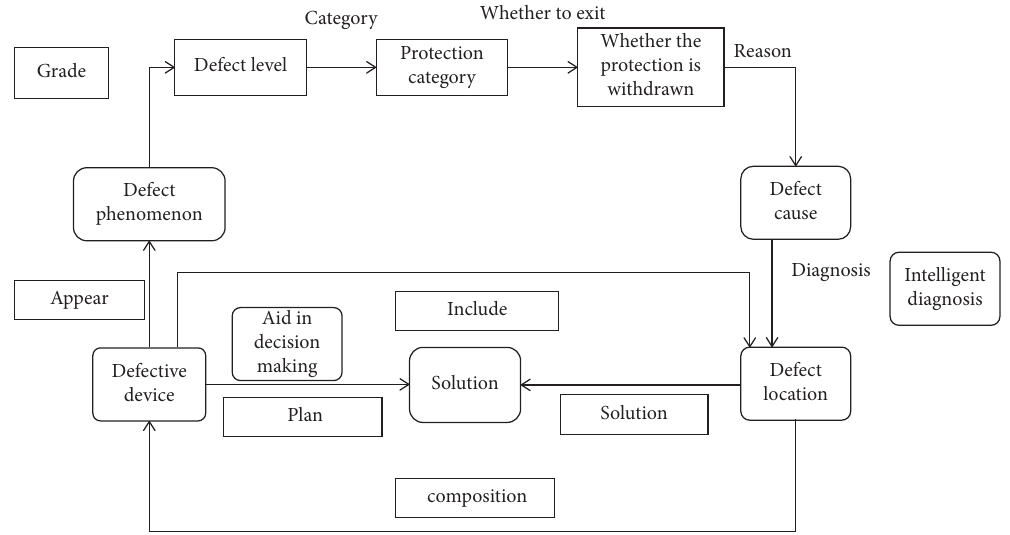
Figure 4: The ontology model of the device knowledge